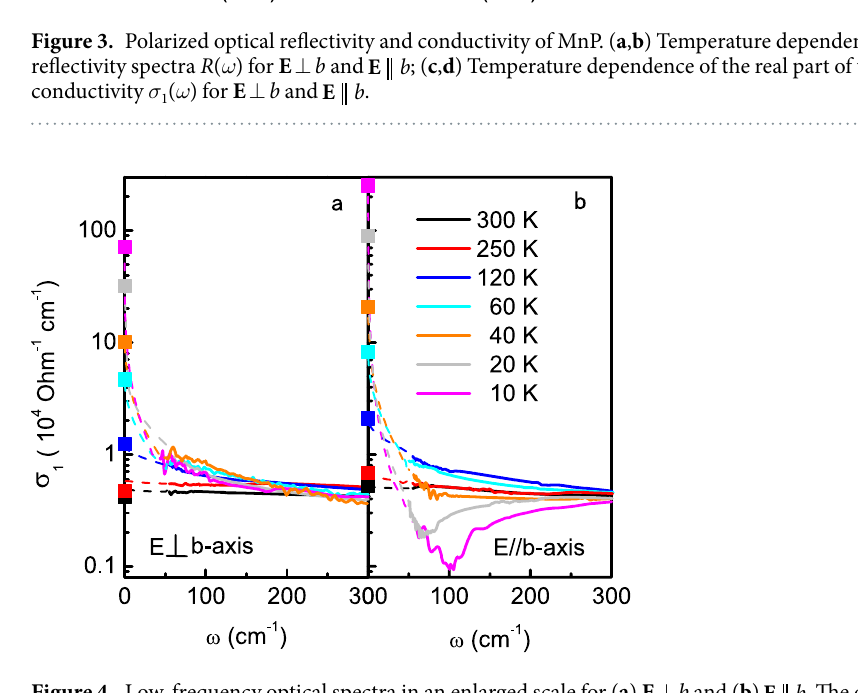
Figure 4. Low-frequency optical spectra in an enlarged scale for ( a ) E ⊥ b and ( b ) b E . The dashed lines represent the extrapolation below 55 cm − 1 using the Hagen-Rubens relation and the Kramers-Kronig transformation. The solid squares at zero frequency indicate the corresponding dc conductivity σ dc = 1/ ρ dc from the resistivity